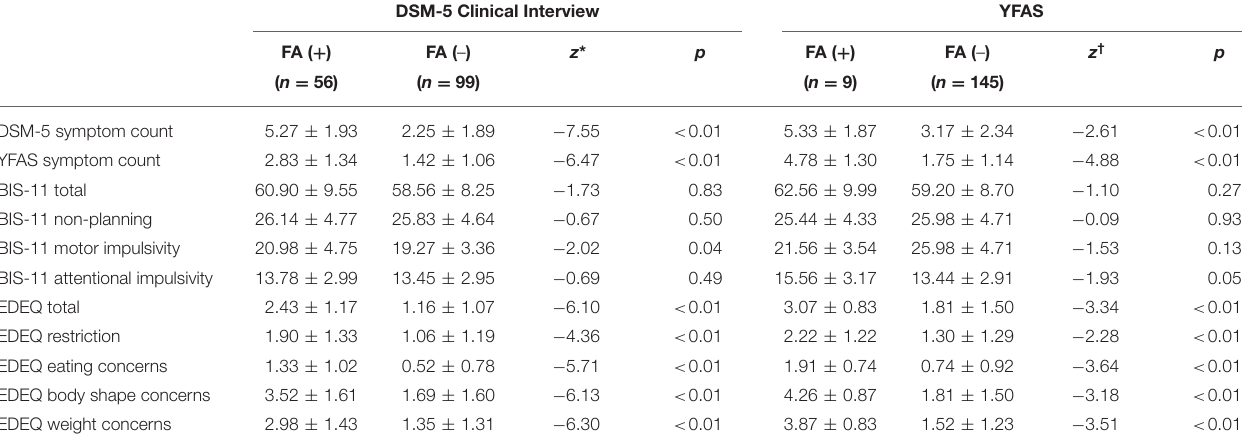
TABLE 5 | Comparison of participants with and without food addiction as assessed by two